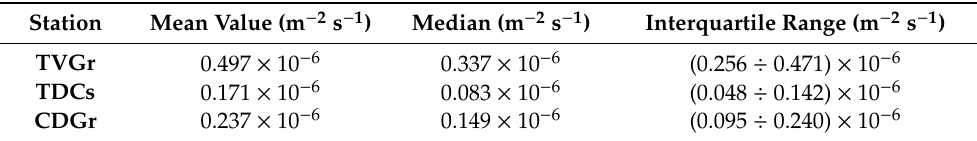
Table 5. The apparent thermal diffusivity of soil D for the three non-urban stations. The reference value is for the soil layer between 0 and 5 cm of depth.